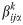
The distribution of βijαk along the environmental gradient.